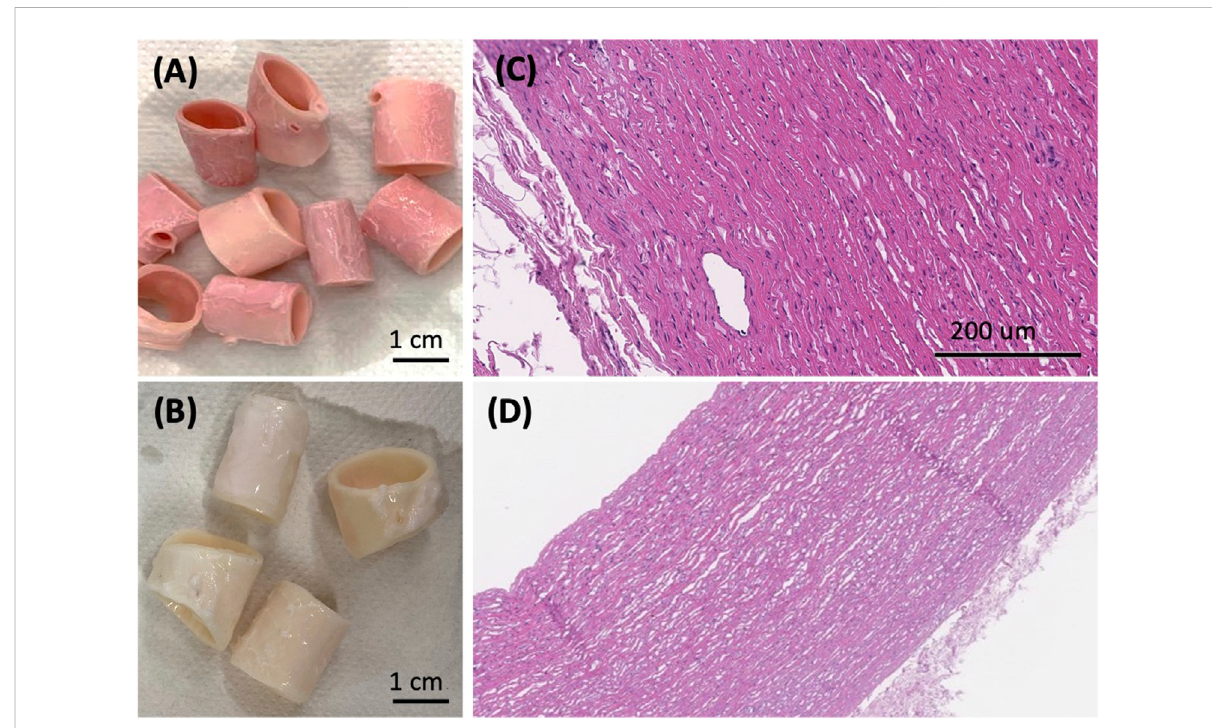
FIGURE 4 (A) Macroscopic appearance of the native aorta and (B) the decellularized samples showing the preservation of the macroscopic structural stability after the decellularization process. Haematoxylin and eosin staining shows the native arterial wall [ (C) , H/E, 40x], and the decellularized arterial wall [ (D) . H/E, 200x], where no nucleated elements are detected after 3 decellularization